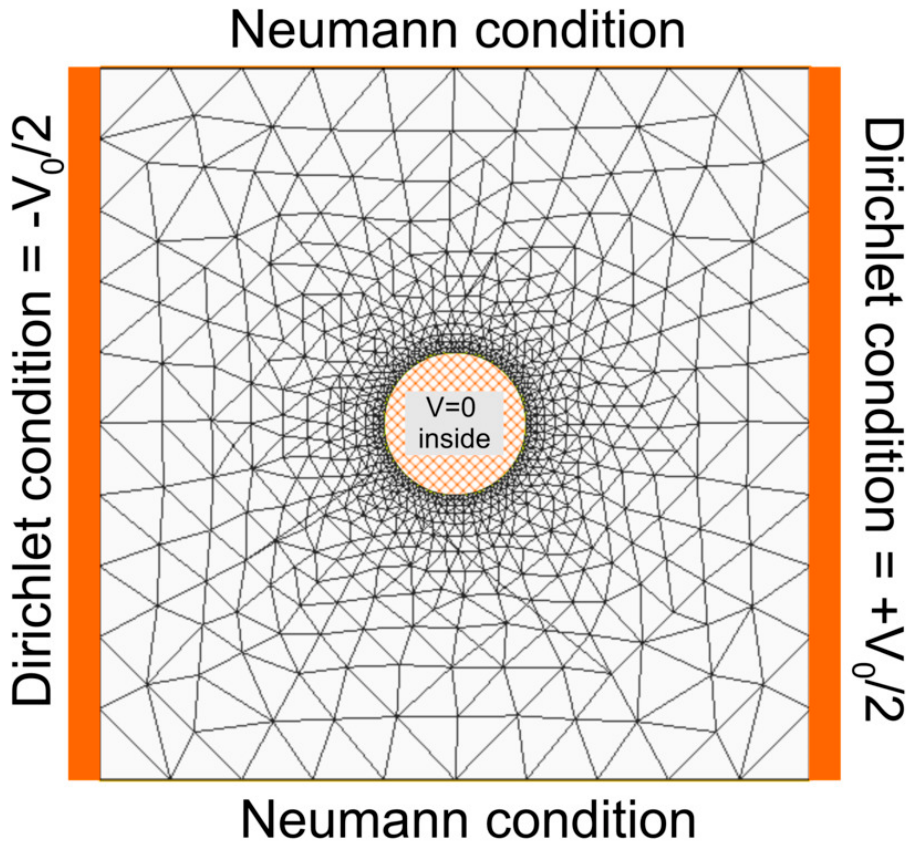
Figure 9. Finite element mesh for the 2D numerical simulations together with the boundary conditions used in the numerical model. The potential is constant inside the metallic particle and is imposed at the external boundaries that correspond to the current electrodes. The potential is computed around the metallic grain in the background material. Modified from [45].